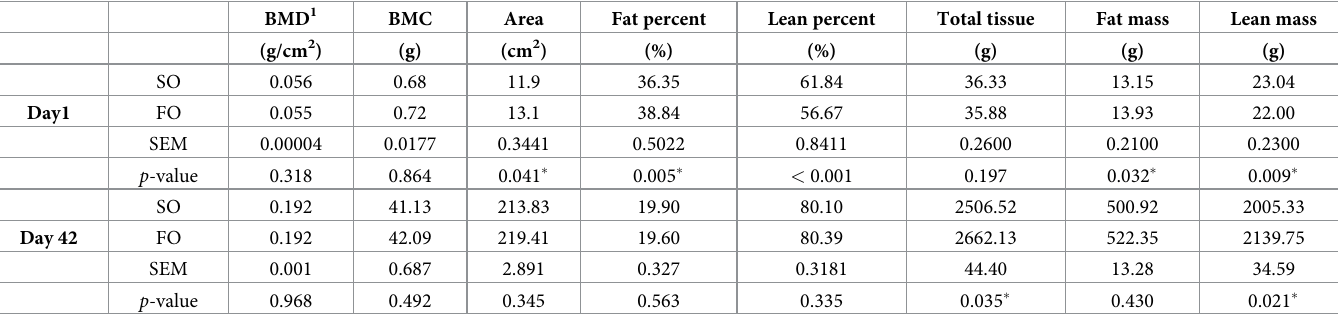
Femurs of market-age broilers were analyzed by μ CT (Fig 1 and Table 5). For total femur bone structure assays, there was a significant decrease of BS/TV in the FO group ( p < 0.05), whereas there were no statistically significant differences in BMD, BMC, TV, BV, BS and BV/TV between two groups (Table 5). Trabecular and cortical bones of the metaphysis were analyzed after 2-D reconstruction and separating. With maternal fish oil consumption, a numerically Table 4. Body composition of broiler chick at 1 day and 42 days of